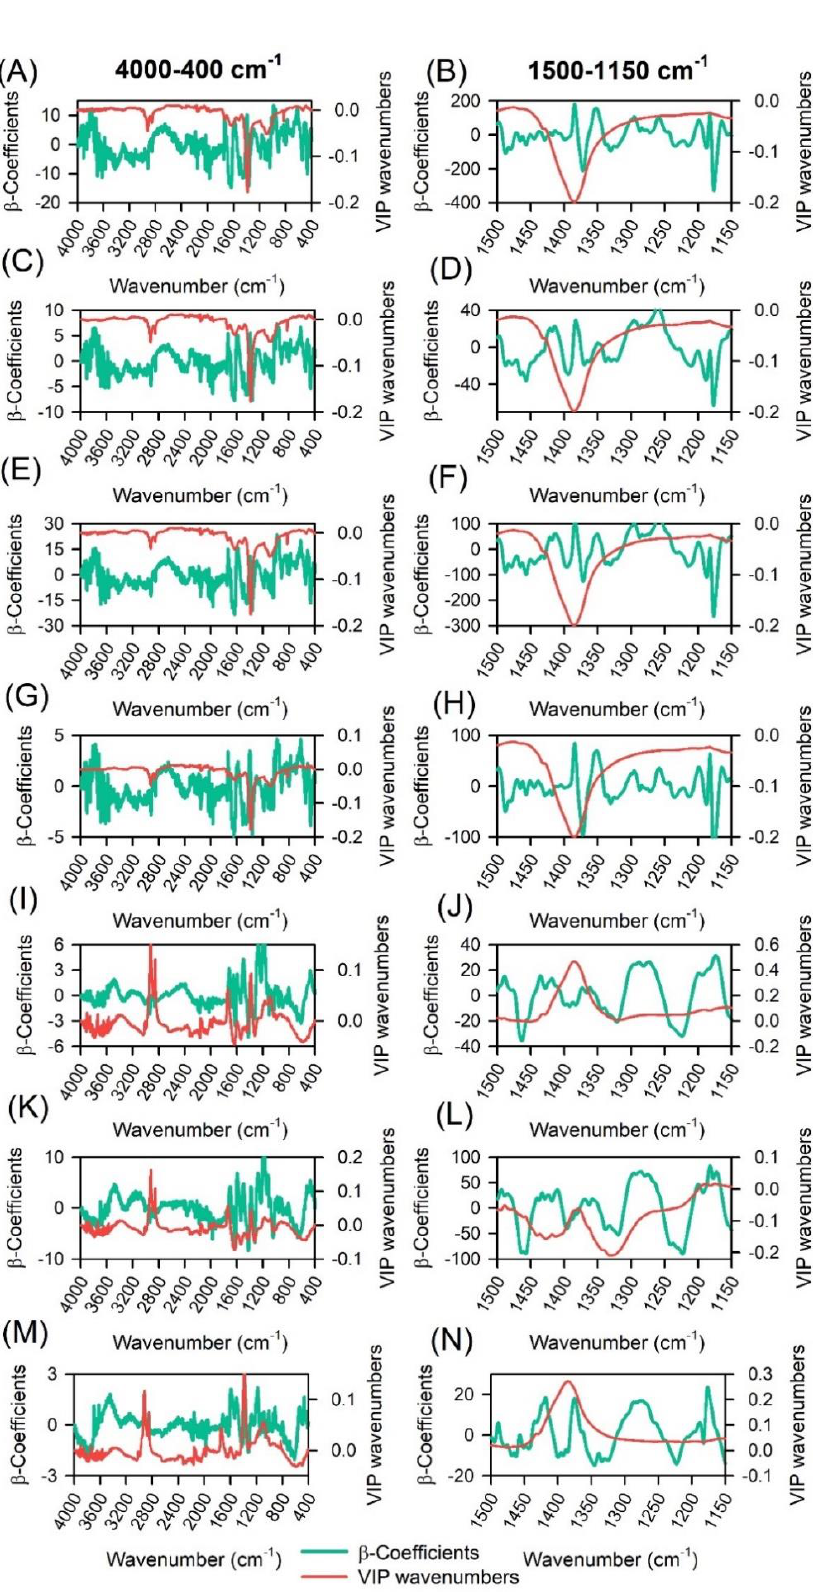
Figure 7. β -Coefficients (RCs) and variable importance to the projection (VIP) method-based ATR-FTIR spectroscopy. ( A , C , E , G , I , K , M ) to 4000 at 400 cm − 1 and ( B , D , F , H , J , L , N ) to 1500 at 1150 cm − 1 by ATR-FTIR spectroscopy. ( A , B ) Chlorophyll a (mg m − 2 ); ( C , D ) Chlorophyll b (mg m − 2 ); ( E , F ) Chlorophyll a + b (mg m − 2 ); ( G , H ) Carotenoids (mg m − 2 ); ( I , J ) Anthocyanins (nmol m − 2 ); ( K , L ) Flavonoids (nmol m − 2 ); ( M , N ) Phenolic compounds (mL L − 1